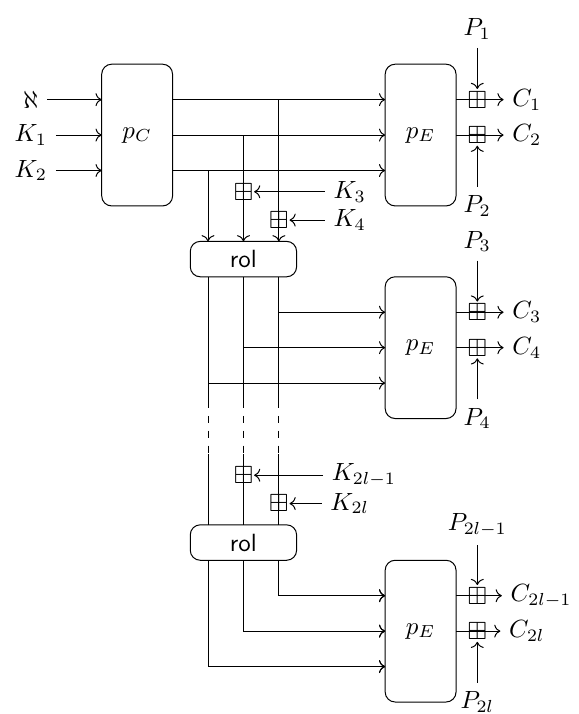
Figure 8: The Ciminion Encryption over F 𝑝 (replace + by ⊕ over F 2 𝑛 ).